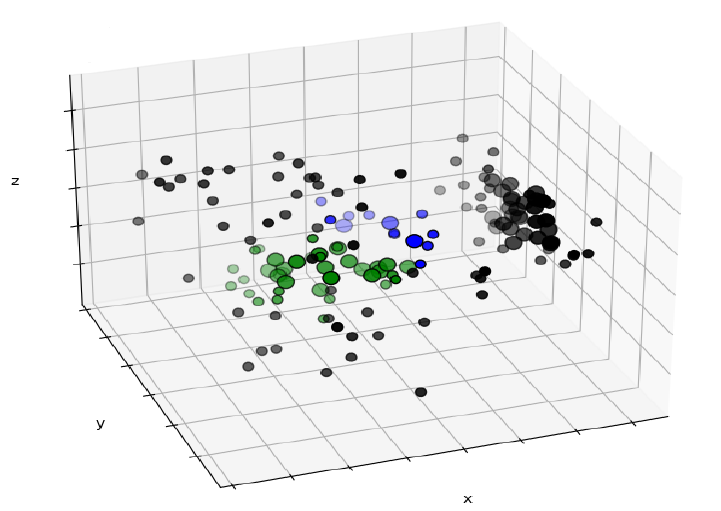
Figure 4. Basic flow chart of experiment.